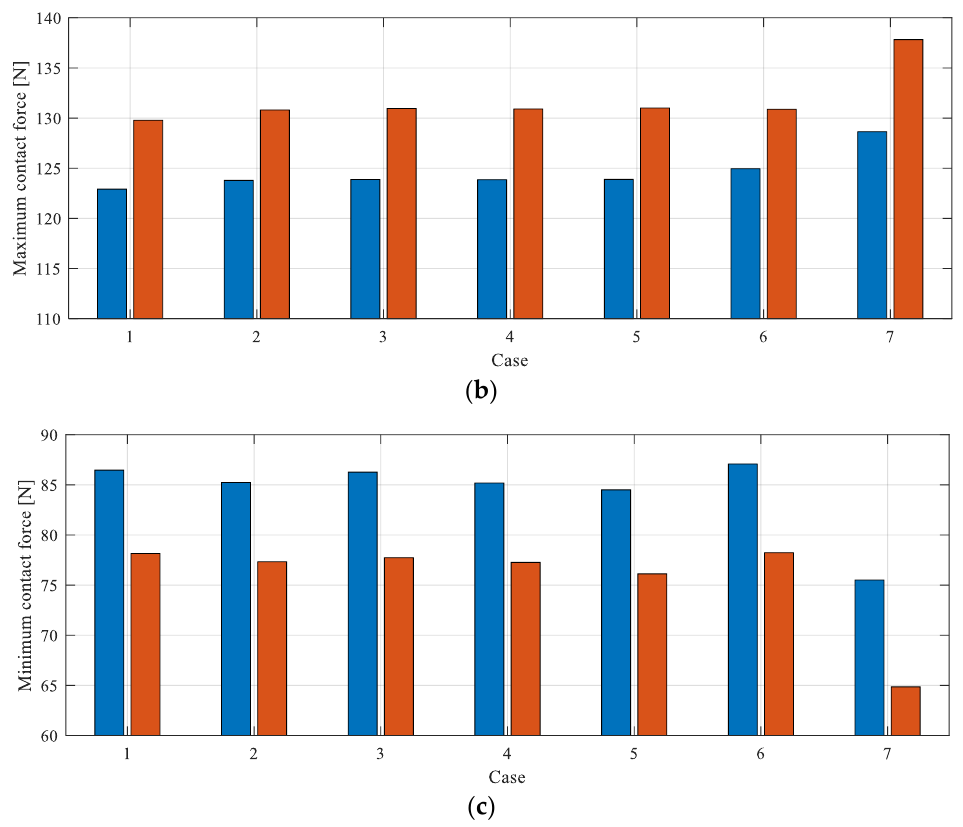
Figure 11. Contact force statistics with different types of conductor rail. ( a ) Presents the resulting contact force standard deviation; ( b ) The resulting maximum contact force; ( c ) The resulting minimum contact force. Cases 1–6 represent the results with conductor rails of large moment of inertia, and Case 7 denotes the result with the previous conventional conductor rail.